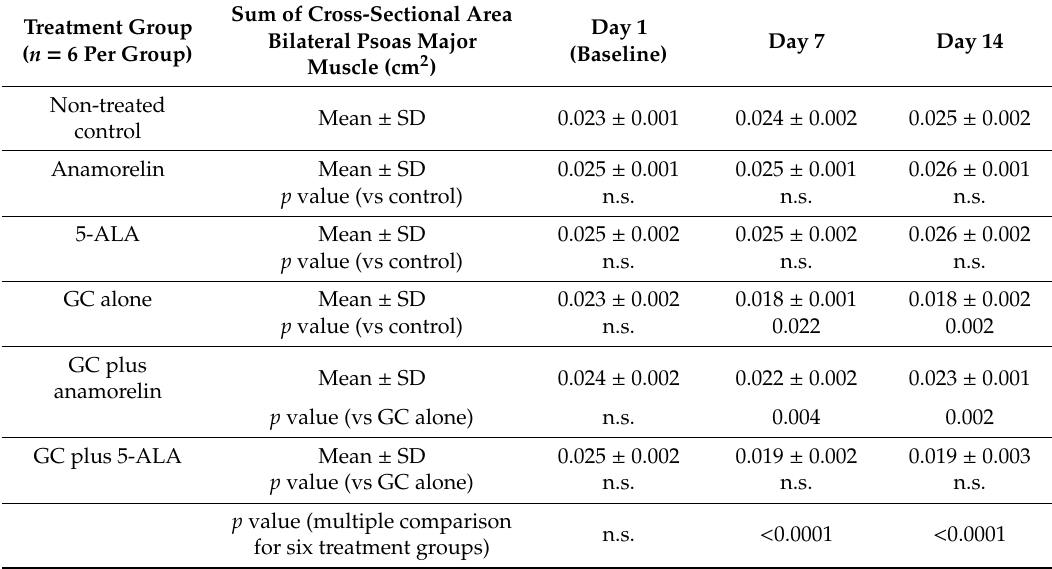
Table 3. Time-course change in the psoas major muscle